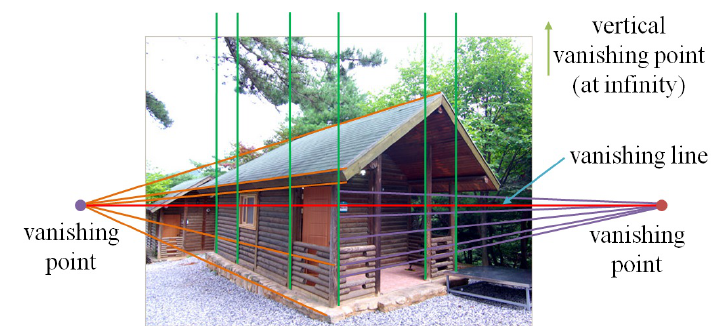
Figure 4. Vanishing lines and vanishing